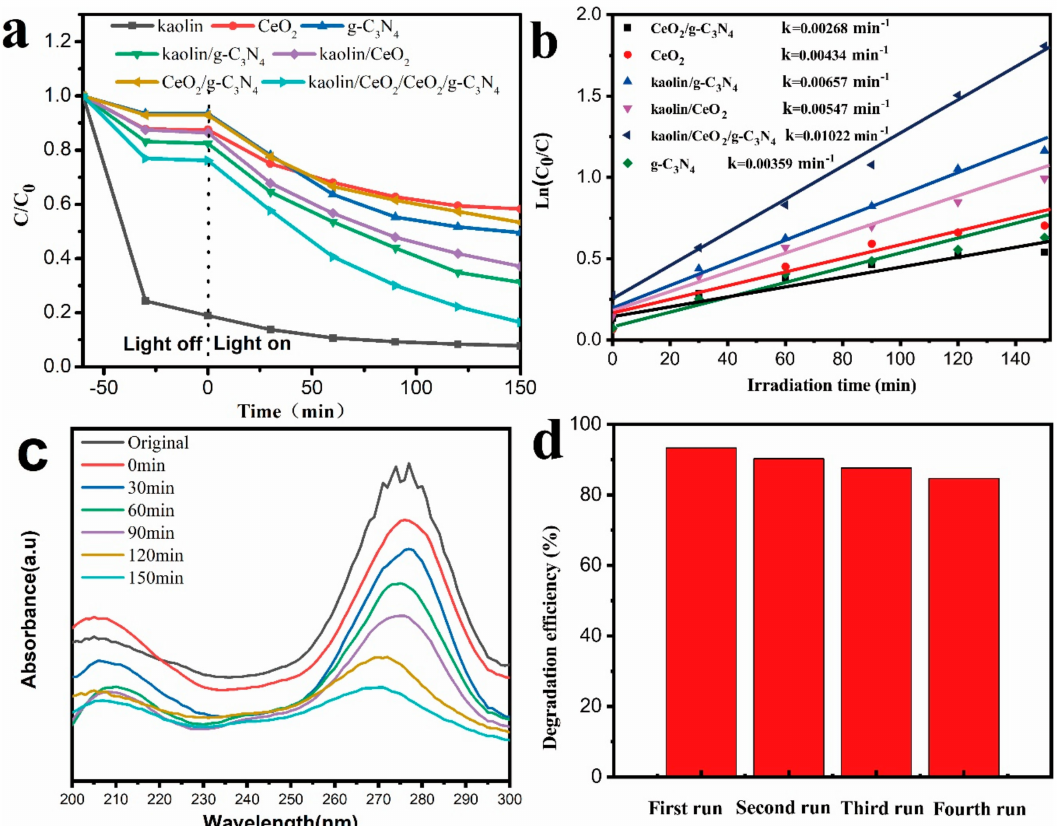
Figure 6. ( a ) Photocatalytic degradation of ciprofloxacin (CIP) under visible light irradiation, ( b ) Linear transform Ln(C0 / C) of the kinetic curves of CIP under visible light irradiation, ( c ) The changes in UV-vis spectra of CIP in liquid phase over the kaolin / CeO 2 / g-C 3 N 4 composite vs irradiation time ( d ) Reusability of the kaolin / CeO 2 / g-C 3 N 4 composite.